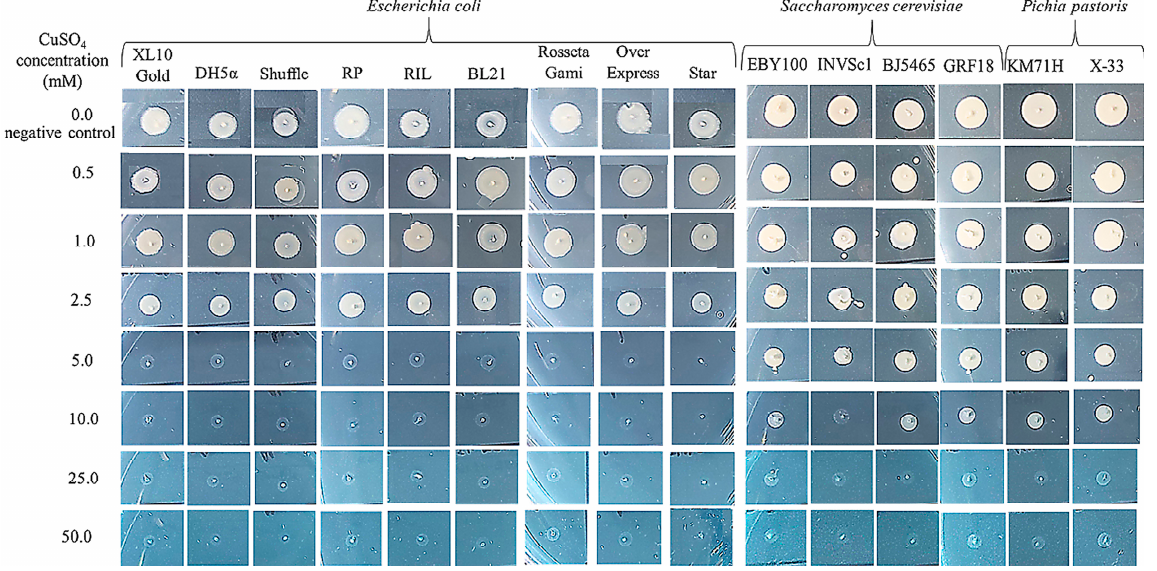
Figure 1. Viability testing of various strains of bacteria and yeast on media with different concentrations of copper sulfate (0 mM—negative control, 0.5, 1.0, 2.5, 5.0, 10.0, 25.0, and 50.0 mM). Copper tolerance testing of three S. cerevisiae strains (BL7, EL1, and GL7) showed that they can tolerate YPD medium containing copper sulfate only up to a concentration of 6.2